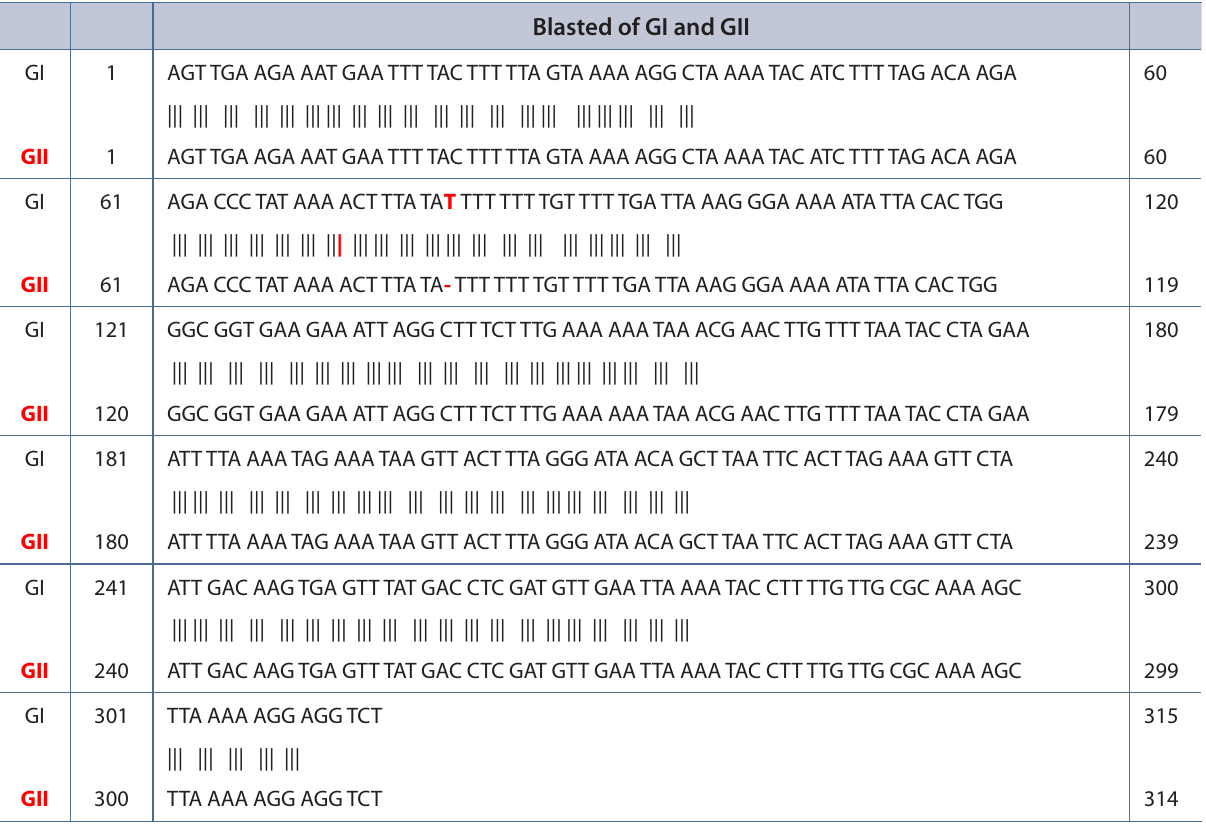
Table 2. BLAST alignment between group I and group II